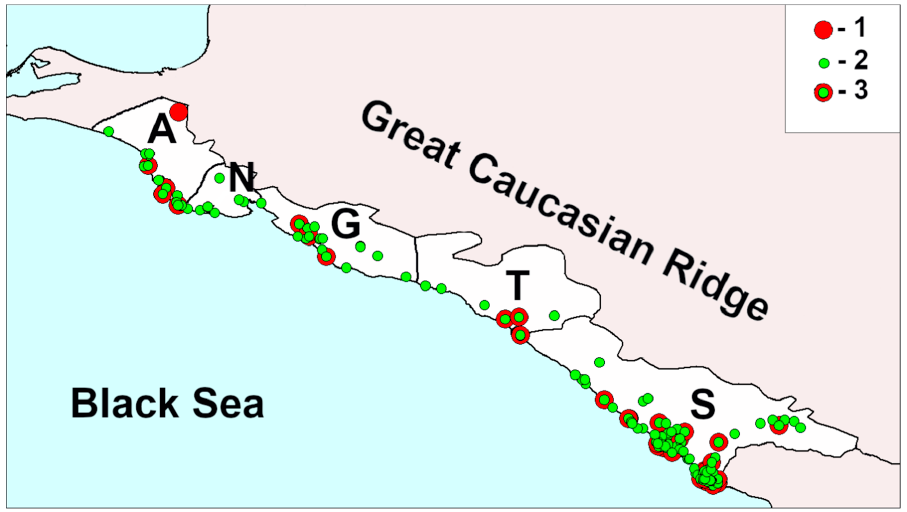
Figure 1. Region of study. A, Anapa; N, Novorossijsk; G, Gelendzhik; T, Tuapsinskiy district; S, Sochi; 1, localities of collection of Harmonia axyridis; 2, localities of collection of other ladybird species; 3, localities where both H. axyridis and other ladybird species were